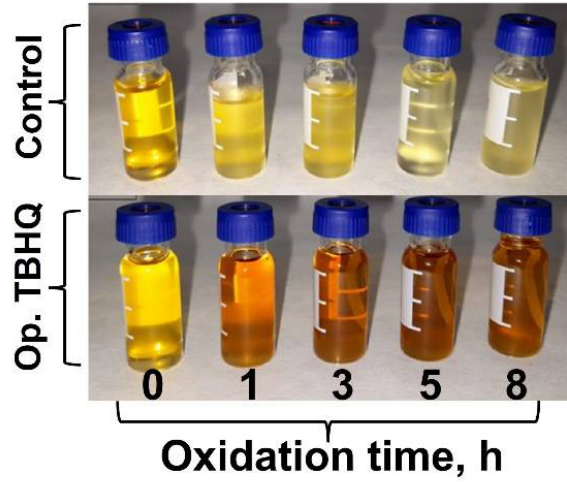
Figure 16. Visual changes during oxidation of FOBL.